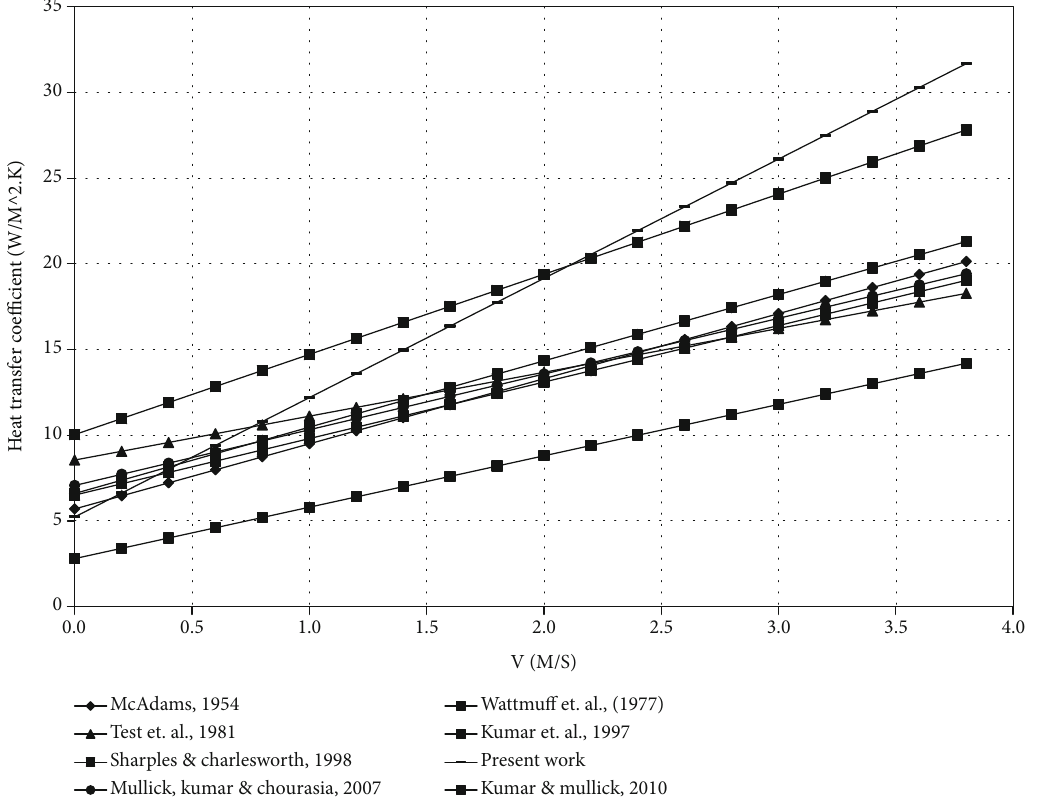
Figure 5: Comparison of previous models with the present model (source: Authors,